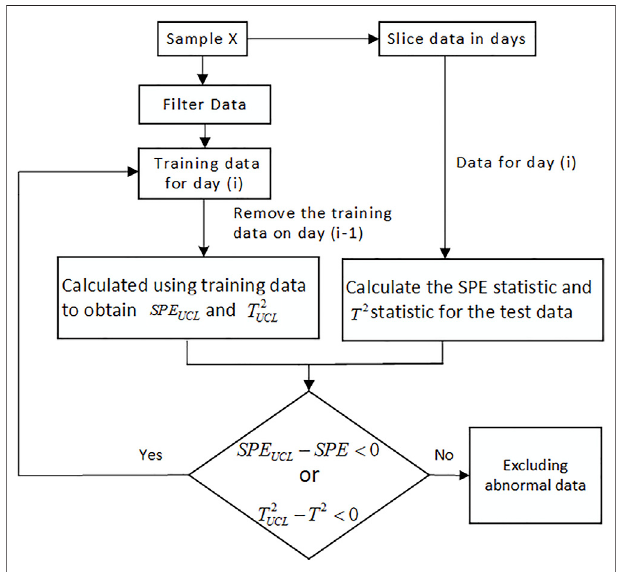
FIGURE 1 | Moving window kernel principal component analysis (MWKPCA) calculation